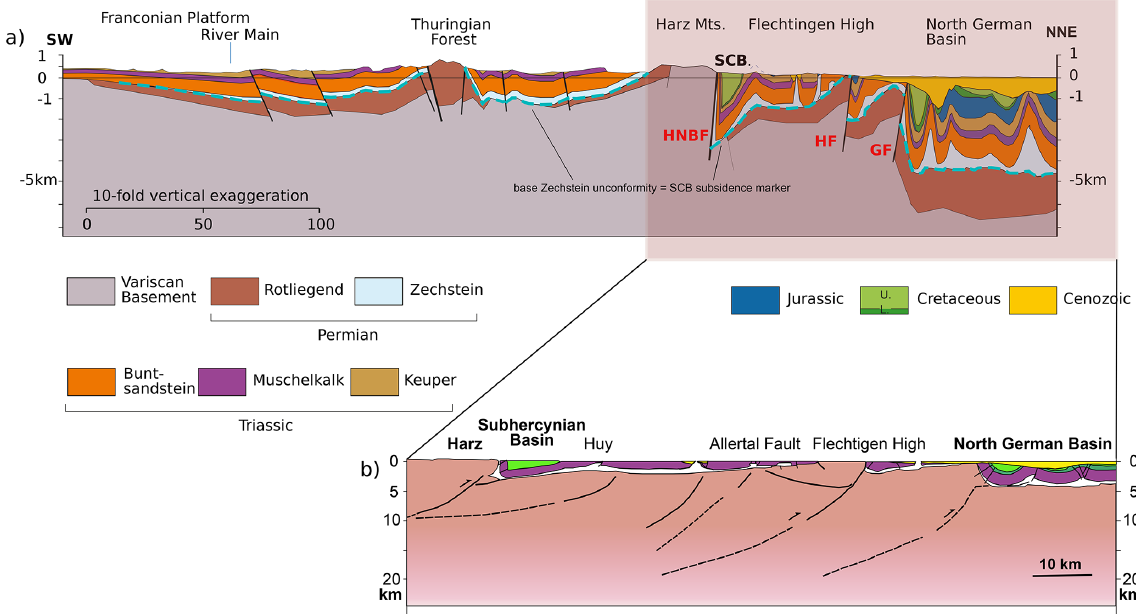
Figure 3. Cross sections across the study area. (a) Vertically exaggerated section emphasizing the geometry of Paleozoic and Mesozoic cover across central and northern Germany. (b) Details of interpreted basement thrusts are adapted from a section of Kley et al.